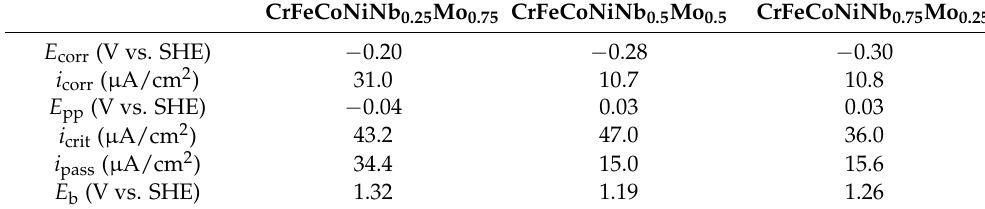
Figure 10. Potentiodynamic polarization curves of as-cast CrFeCoNiNb x Mo 1 − x alloys tested in the 1M deaerated sodium chloric solution at 30 ° C. Table 8. Potentiodynamic polarization data of the as-cast CrFeCoNiNb x Mo 1 − x alloys in 1M deaerated NaCl solution at 30 ° C.